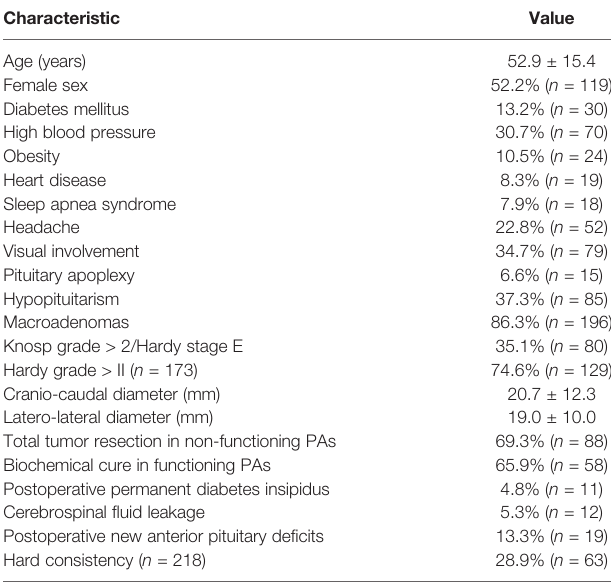
TABLE 1 | Patient and tumor characteristics of the study cohort at